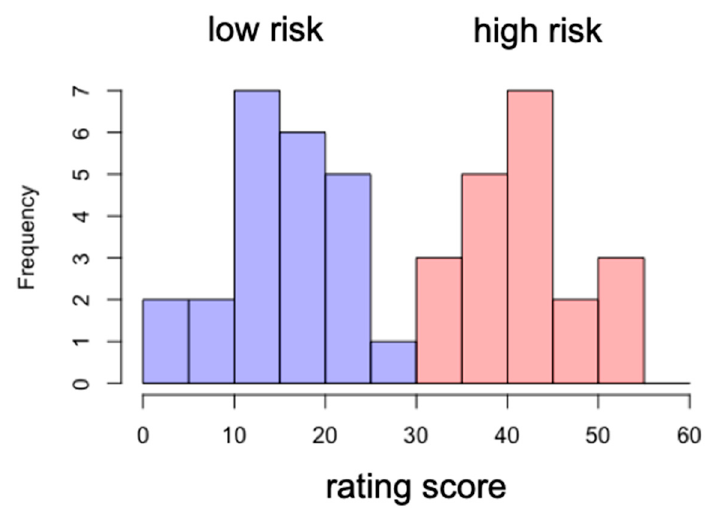
Figure 3. Distribution of rating scores for low-risk and high-risk groups.